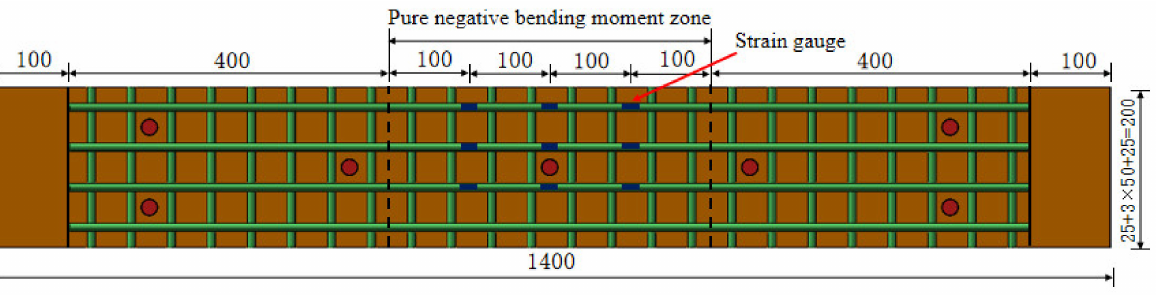
Figure 9. Arrangement of strain gauges on steel bars (Dimensions in